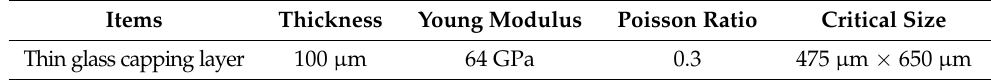
Table 2. Glass capping layer parameters.